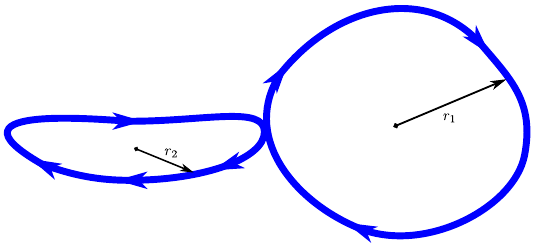
Figure 5 . A schematic plot of the formation of two axion string loop with radius r 1 and r 2 from a self crossing event. The surface of the two circular loops are perpendicular to each other so that the mutual inductance is